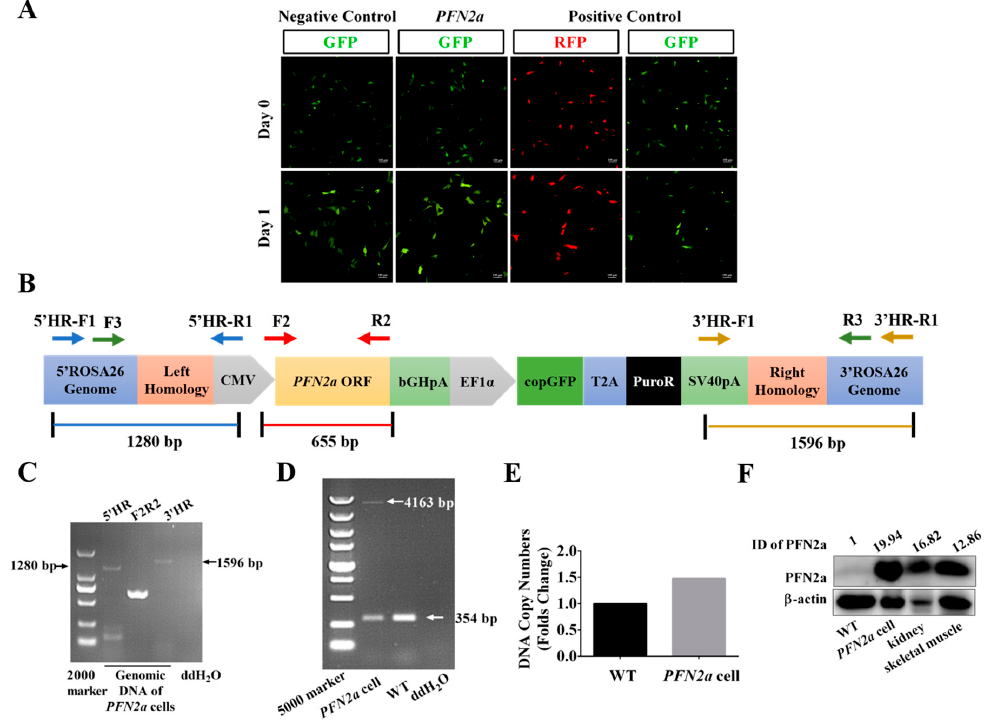
Figure 1. PFN2a knock-in at ROSA26 locus of C2C12 cells. ( A ) Monoclonal cell screening. The MCP- ( A ) Monoclonal cell